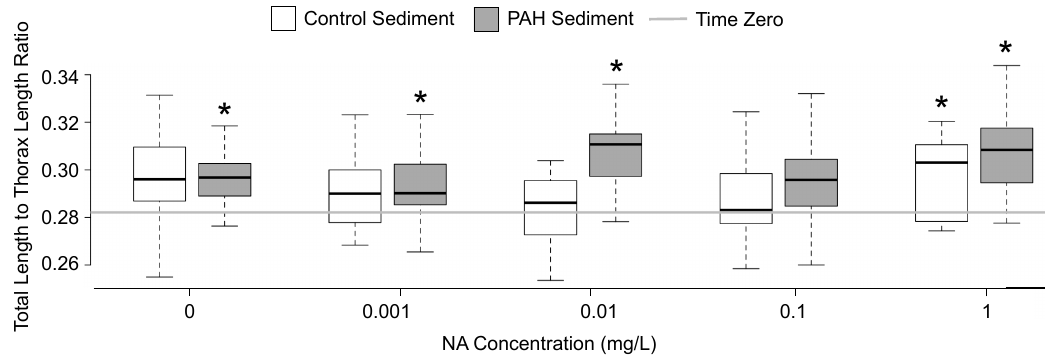
Figure 5. Boxplot comparison of total length to thorax length ratios (showing the maximum, 75 th percentile, median, 25 th percentile, and minimum) in total length to thorax length ratio in Hexagenia mayfly nymphs exposed to an NA mixture in either control (white, left) or PAH-spiked sediment treatments for a 21-day period. Significant differences from the control (0 mg/L NA and control sediment, far left bar) are indicated by “*” and the time zero measurements are indicated by a grey horizontal line for comparison.